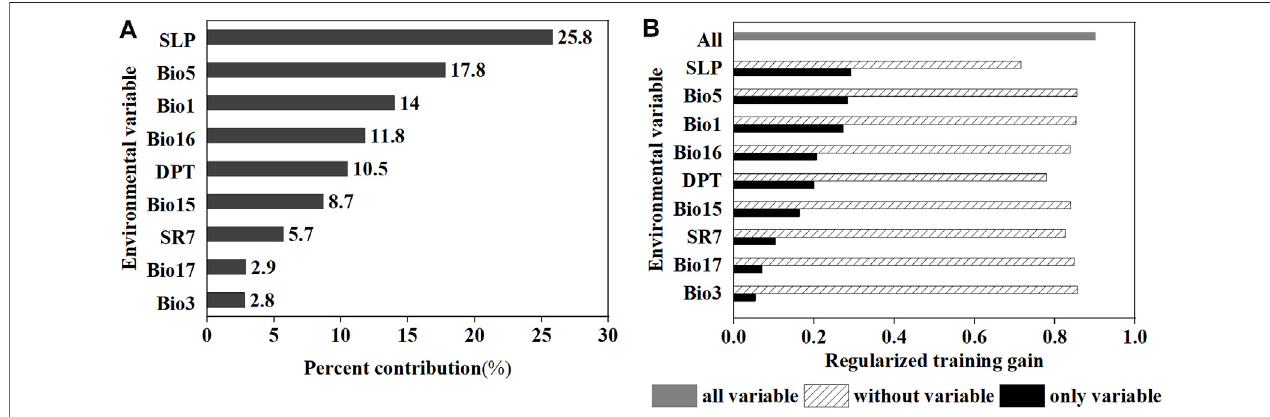
FIGURE2| Evaluationofthesigni fi cantenvironmentalpredictors: (A) theestimatesofpercentcontributionsoftheenvironmentalvariablestotheMaxentmodel; (B) jackknife test evaluating the signi fi cant environmental variables on the distribution of Jerusalem artichoke.